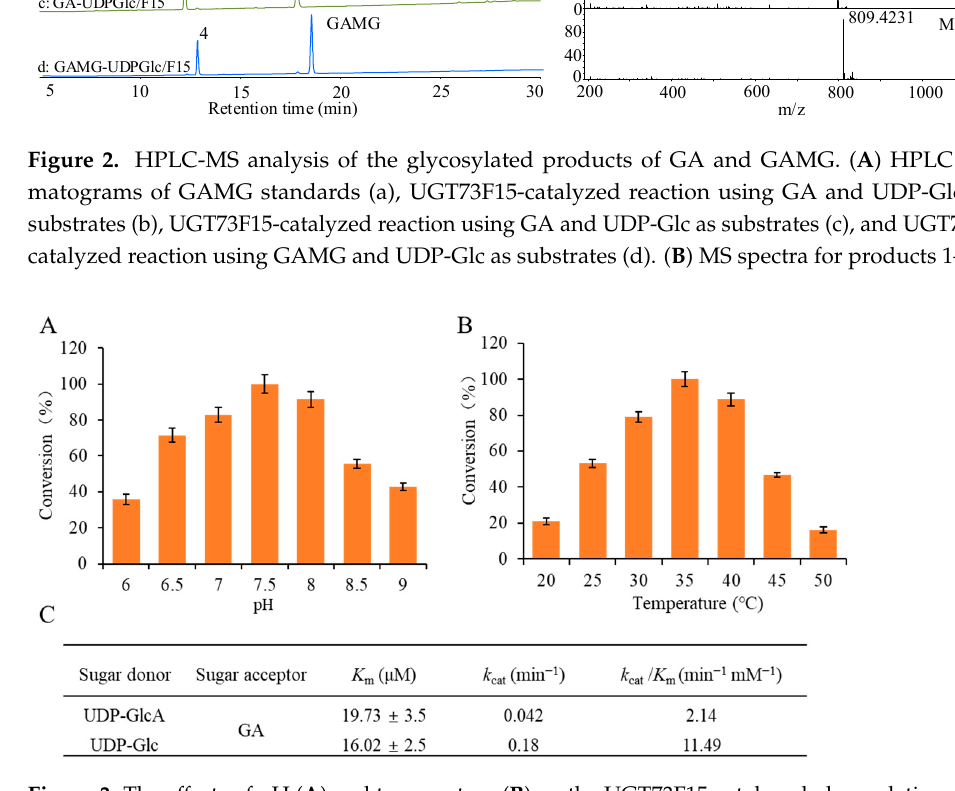
Figure 3. The effects of pH ( A ) and temperature ( B ) on the UGT73F15-catalyzed glycosylation of GA. ( C ) Kinetic parameters of UGT73F15 toward GA using UDP-GlcA or UDP-Glc as sugar donor. Error bars represent the standard deviation from three repeats.